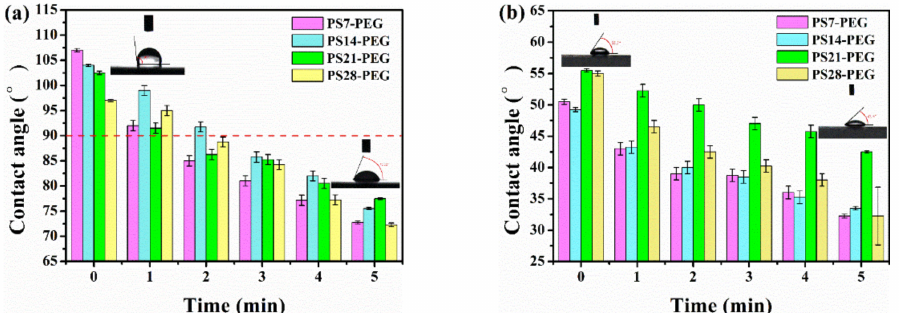
Figure 11. PS-PEG hydrogel dynamic contact angle ( a ) DWCA; ( b )